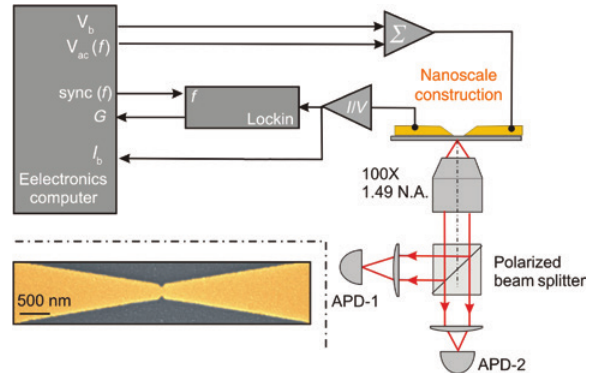
Figure 1: Experimental setup used for measuring simultaneously electron transport and light emission during the electromigration of a Au constriction shown in the